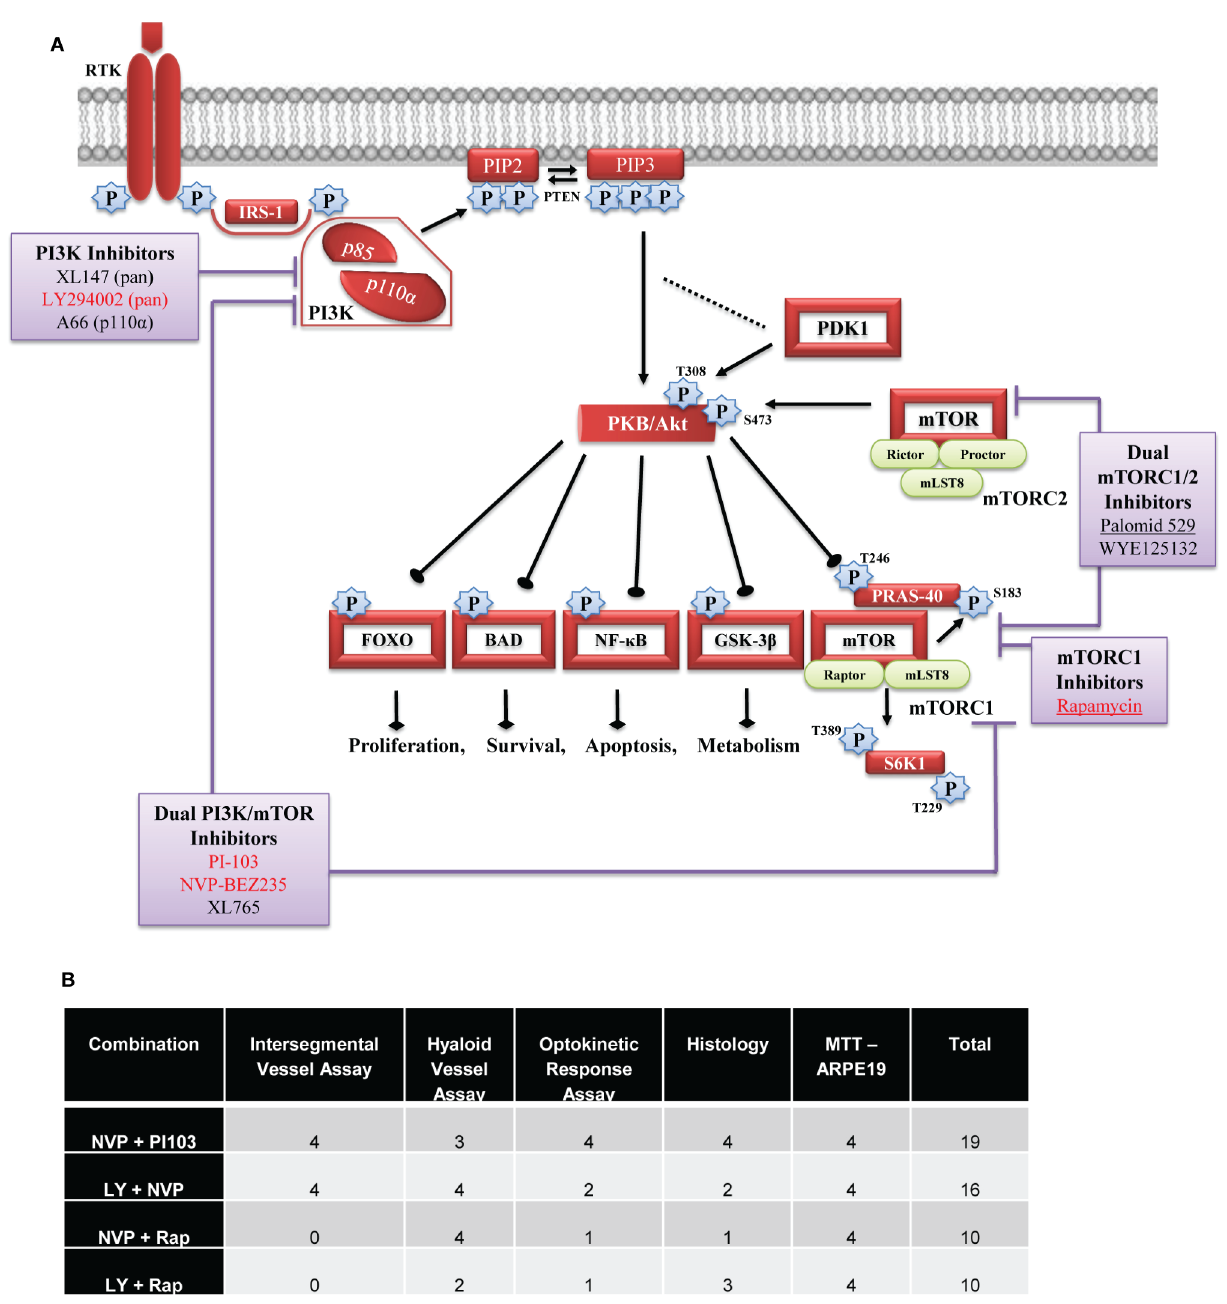
Figure 7. Diagrammatic representation of PI3K/AKT/mTOR signalling pathway detailing tested drug targets and overall ranking table. Upon activation by receptor tyrosine kinase, PI3K lipid kinases are recruited to the plasma membrane where they phosphorylate PIP 2 to form PIP 3 . Once phosphorylated, the second messenger PIP 3 can bind and activate AKT which can then trigger an array of downstream signalling events. The site of action tested drugs is indicated and the most effective drugs are depicted in red, and underlined drugs are in clinical trial for ocular indications (A). Table illustrates the overall ranking of the top PI3K/AKT/mTOR inhibitor combinations in the ISV, HV, OKR, LM and MTT experimental assays (B).